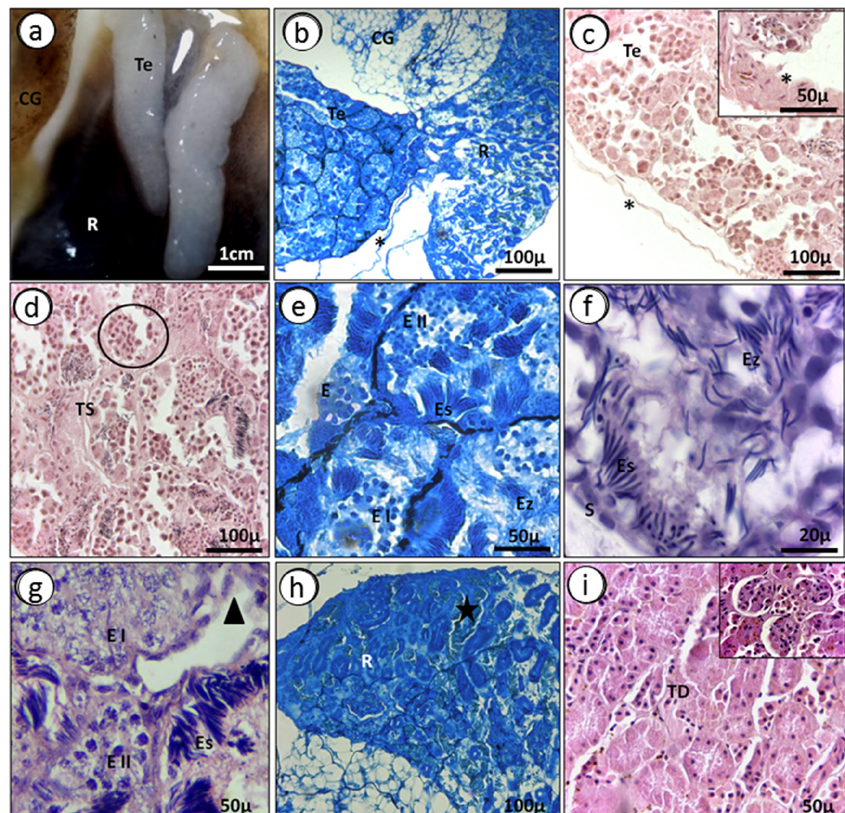
Figure 2. a) Detail of the testes with tunica albuginea without pigmentation, kidneys and fat bodies in S. acuminatus . b) Sagittal section of testicles, kidneys and fat body (Staining: Coomassie blue). c) Transversal section of the testicle with detail of the tunica albuginea (Staining: H-E). d) Detail of the seminiferous tubules with cysts (Staining: H-E). e) Detail of the cell types each spermatogenic cyst and seminiferous tubules surrounded by melanocytes (Staining: Coomassie blue). f) Detail of plume of spermatids attached to the Sertoli cell (Staining: PAS). g) Detail of the interstitial cells and Leydig cells (Staining: H-E). h) Transversal section of the kidney, with emphasis on the convoluted tubules that are part of the sexual segment (Staining: Coomassie blue). i) Detail of the convoluted tubules of the hypertrophied sexual segment with positive PAS cells and detail of the genital glomerulus (Staining: PAS). References : Te: testicle. CG: fat bodies. R: kidney. Asterisk: tunica albuginea. TS: seminiferous tubule. Circle: cistos. Me: melanocytes. E: spermatogonia. EI: primary spermatocytes. EII: secondary spermatocytes. Esp: spermatids. Ez: sperm. S: Sertoli cells. Star: hypertrophied contiguous tubules. TD: distal contiguous tubules. Arrowhead: Leydig